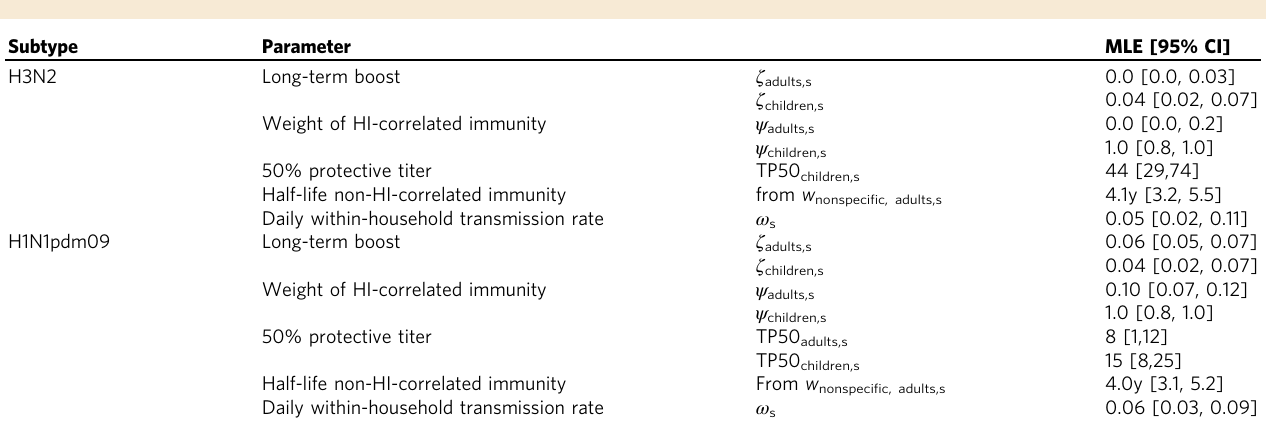
Table 1 Maximum likelihood estimates and 95% con fi dence intervals (CI) Subtype